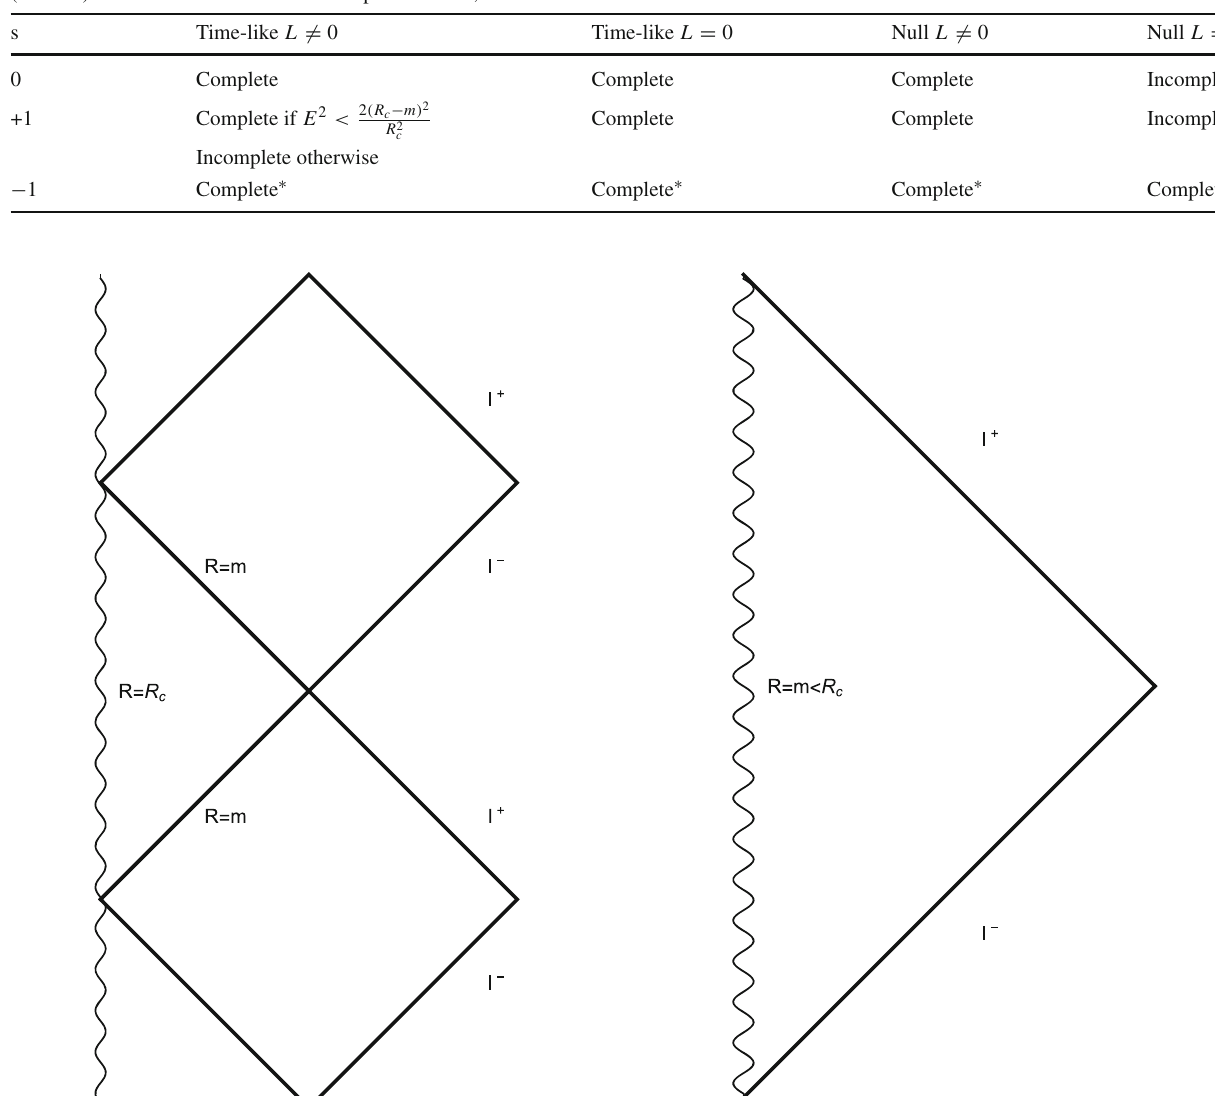
Fig. 5 Conformal diagram of the case m < R c when s = + 1.